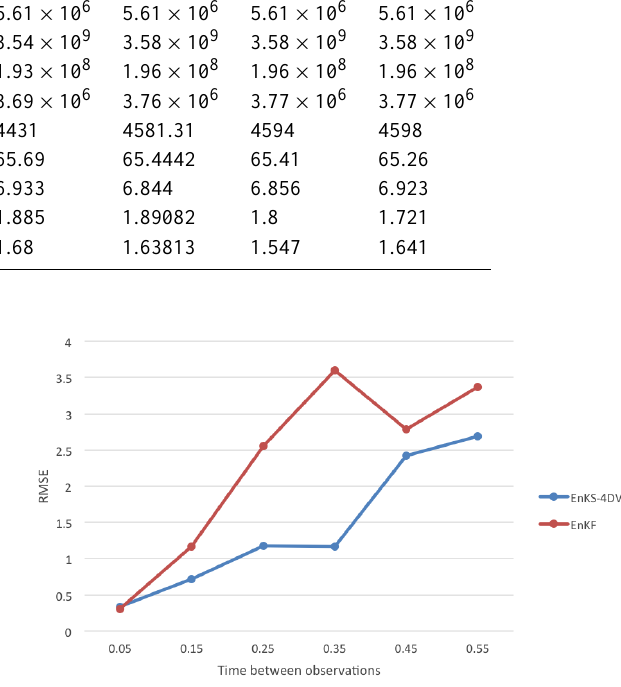
Figure 5. Comparison of the RMSE between EnKF and EnKS- 4DVAR from the twin experiment for the Lorenz 63 model. EnKS- 4DVAR has better performance for the larger time interval be- tween the observations as the model become more nonlinear. See Sect. 5.1.3 for further